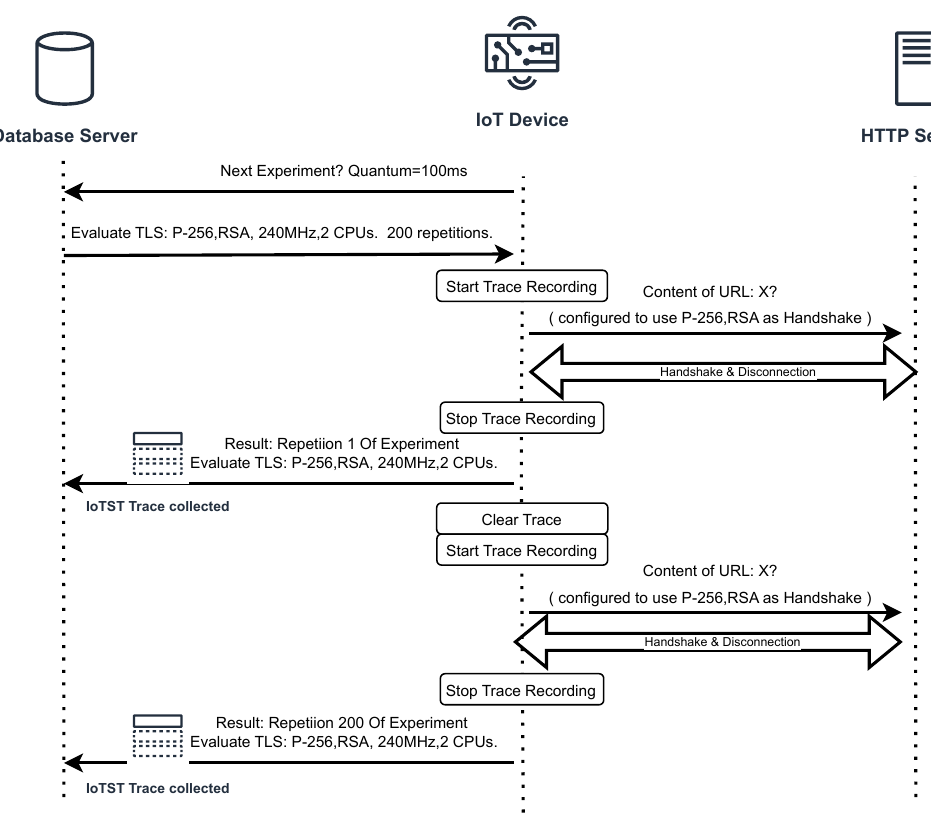
Figure 2. Generic IoTST computing architecture.